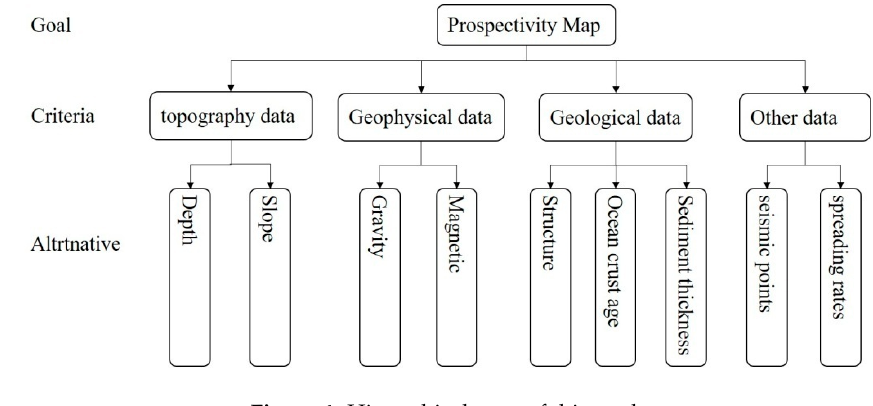
Figure 4. Hierarchical trees of this study. Table 3. Pairwise comparison matrix with respect to criteria.